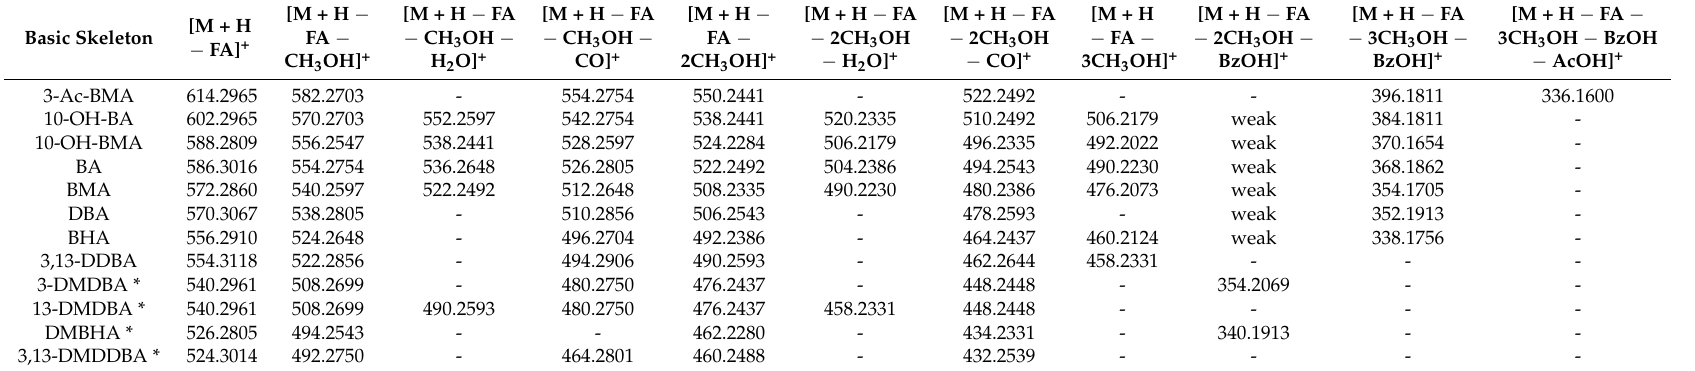
Table 1. MS/MS characteristic fragmentation ions of aconitane skeletons in lipo-alkaloids a